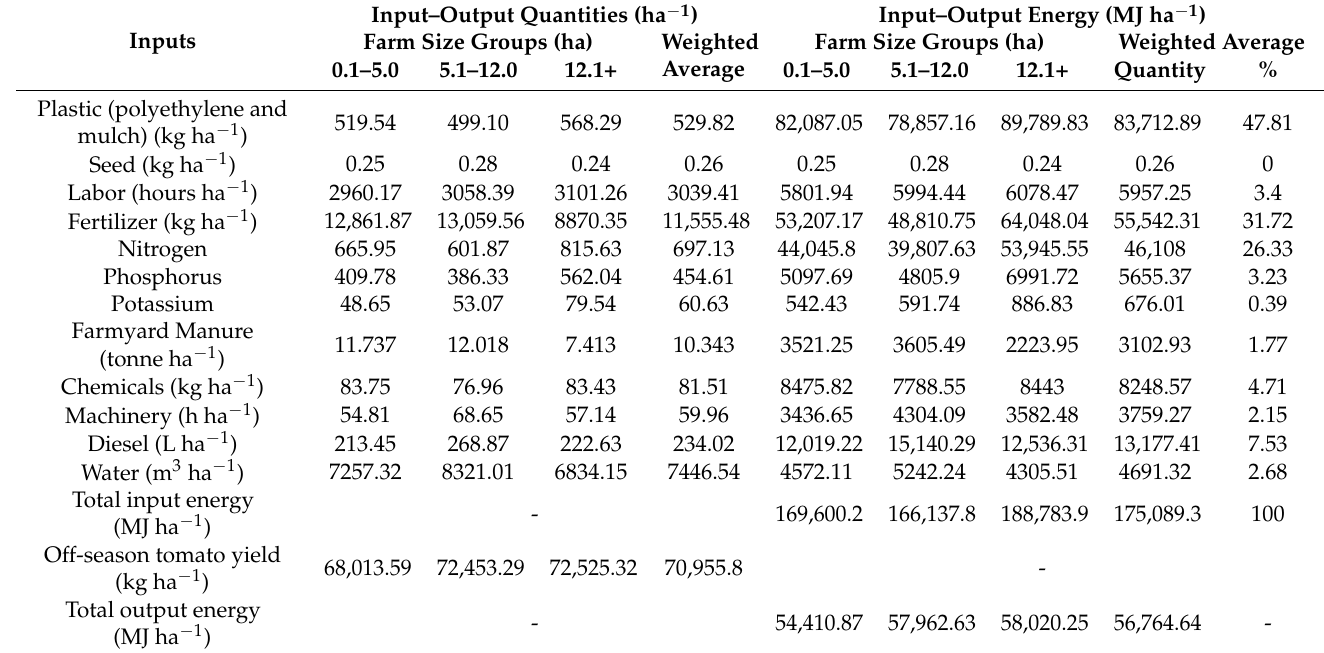
Table 3. Input usage and energy consumption in off-season tomato